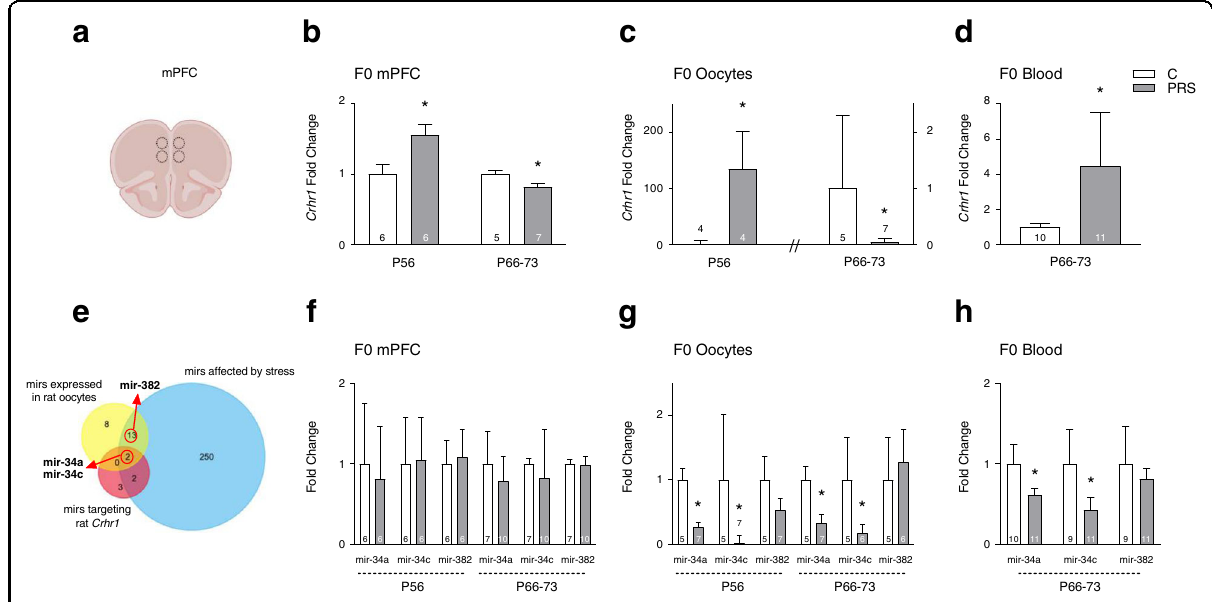
Fig. 2 PRS-induced Crhr1 mRNA and miRNA expression changes in F0 females. In mPFC ( a ), Crhr1 mRNA is elevated in PRS-exposed rats on P56 (one-way ANOVA, F 1,10 = 6.2, p < 0.05), and decreased to below control levels by P66-73 ( b; one-way ANOVA, F 1,10 = 6.9, p < 0.05), and a similar pattern is observed in oocytes ( c ; P56: one-way ANOVA, F 1,6 = 7.0, p < 0.05; P66-73: one-way ANOVA, F 1,10 = 5.91, p < 0.01). d In blood, Crhr1 mRNA is increased in PRS-exposed rats at P66-73 (one-way ANOVA, F 1,19 = 9.138, p < 0.01). e Venn diagram demonstrating selection of miRNA molecules assessed in current study: mir-34a and mir-34c, but not mir-382, target Crhr1 . All three miRNAs are involved in the stress response and are expressed in oocytes. f No PRS-induced changes in mir-34a, mir-34c, and mir-382 expression in mPFC at either time point. g Mir-34a and mir-34c expression is decreased in oocytes of PRS-exposed rats on P56 (one-way ANOVA, F 1,10 = 10.2, p < 0.01, F 1,10 = 7.2, p < 0.05, respectively) and at P66-73 (one-way ANOVA, F 1,10 = 5.69, p < 0.05, F 1,9 = 5.15, p < 0.05, respectively), with no change in mir-382 at either time point. h Mir-34a and mir-34c, but not mir- 382, expression is decreased in blood of PRS-exposed rats (one-way ANOVA, F 1,19 = 6.621, p < 0.05, F 1,18 = 4.67, p < 0.05, respectively). Data presented as means and standard errors of fold-change, relative to C. * post-hoc/one-way ANOVA p ’ s <